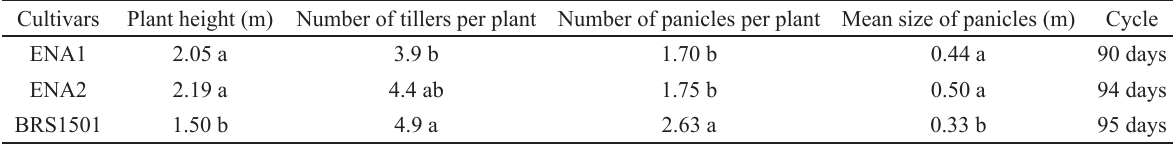
Plant height, number of panicles per plant, mean size of the panicles and cycle of three pearl millet cultivars.